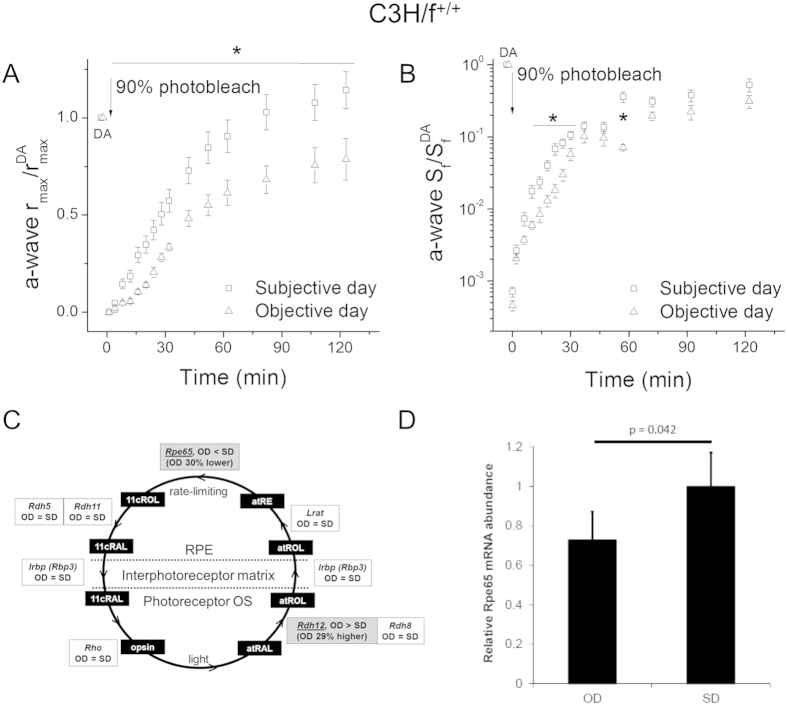
Effect of the light history on rod dark adaptation in melatonin-proficient C3H/f+/+ mice.(A) Normalized in vivo ERG scotopic a-wave maximal response (a-wave rmax/a-wave rDAmax) recovery in C3H/f+/+ mice following 90% pigment bleach at t = 0 at subjective day (replotted from Fig. 1C, open squares) and objective day (open triangles, n = 7) (*p < 0.05). (B) Normalized in vivo ERG scotopic a-wave sensitivity (a-wave Sf/a-wave SfDA) recovery in C3H/f+/+ mice following 90% pigment bleach at t = 0 at subjective day (replotted from Fig. 1D, open squares) and objective day (open triangles, n = 7) (*p < 0.05). (C) Components of the RPE visual cycle and their expression by RNA-seq in objective day (OD) vs. subjective day (SD). In the photoreceptor outer segment (OS), the absorption of light by rhodopsin (Rho) causes conversion of 11-cis retinal (11cRAL) to all-trans retinal (atRAL). Next, atRAL is reduced to all-trans retinol (atROL) by RDH8 or RDH12 and exported to the RPE. There, atROL is converted to all-trans retinyl-ester (atRE) by LRAT. Subsequently, atRE is converted to 11-cis retinol (11cROL) by RPE65 in a rate-limiting step. Finally, 11cROL is oxidized to 11cRAL by RDH5 or RDH11 and imported back into the OS. IRBP is a binding protein in the interphotoreceptor matrix. Comparison of gene expression levels in OD vs. SD: gray shading indicates a significant difference at FDR  =  0.05. (D) Rpe65 mRNA abundance in objective day (OD) vs. subjective day (SD) in C3H/f+/+ mice as quantified by qRT-PCR. Transcript levels of Rpe65 were normalized to Gapdh. Error bars represent standard error of the mean (SEM) across five biological replicates per condition. P-value, two-tailed Student’s t-test.